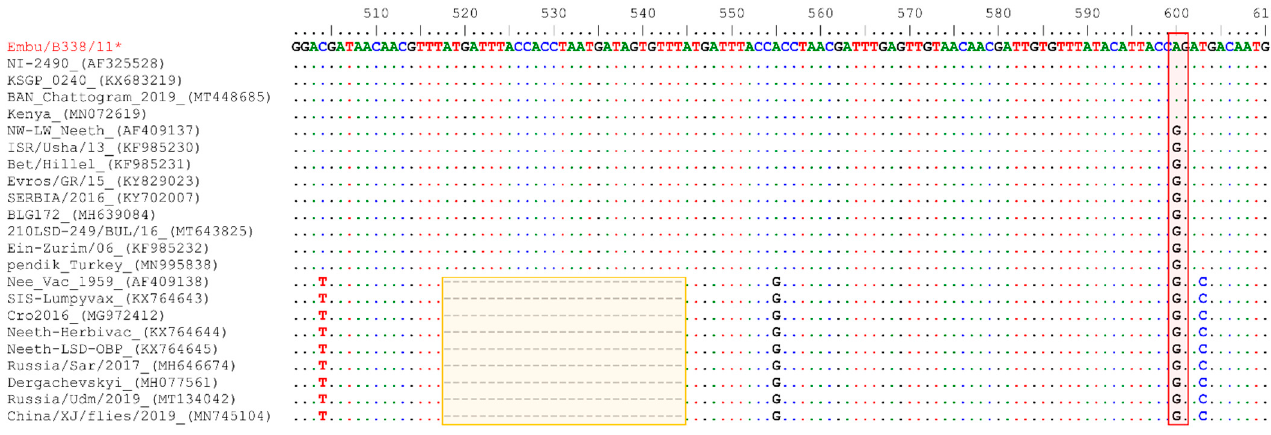
Figure 4. Multiple sequence alignments of the partial EEV glycoprotein nucleotide sequences of LSDV Embu/B338/2011 (highlighted in red, with a star after the name) with sequences of 22 additional LSDVs retrieved from GenBank. A unique sequence signature of 27 nucleotides only in LSDV Neethling-like viruses is highlighted in the box. Note also the A to G change highlighted the red box. Identical nucleotides are indicated with dots.